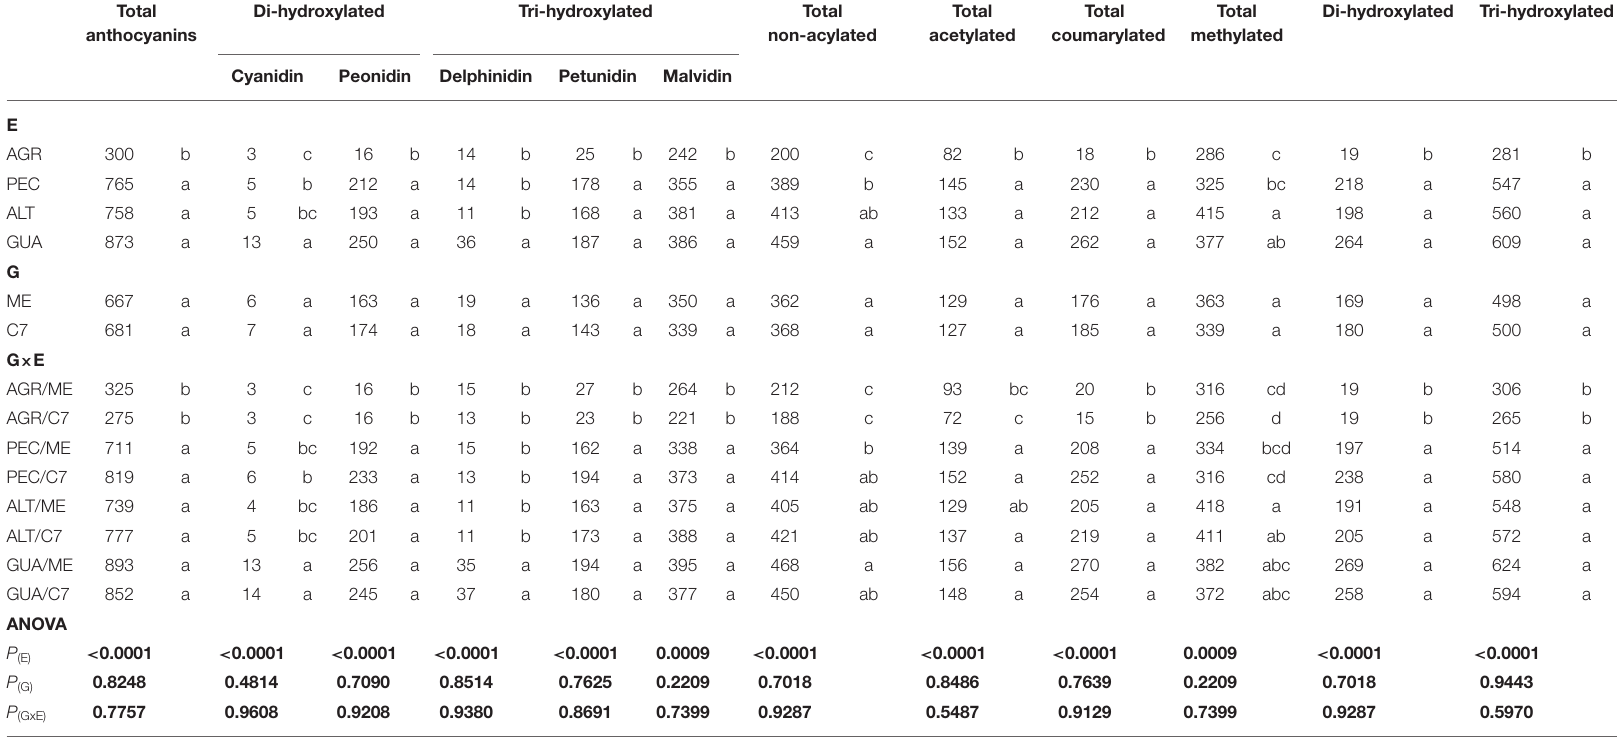
Values are means (mg L − 1 wine) of three replicates (n = 3) and different letters within a column indicate statistically significant differences between extracts (LSD Fisher test, P < 0.05). P ( E ) , P ( G ) and P ( G × E ) : effects of environment, genotype and their interaction,